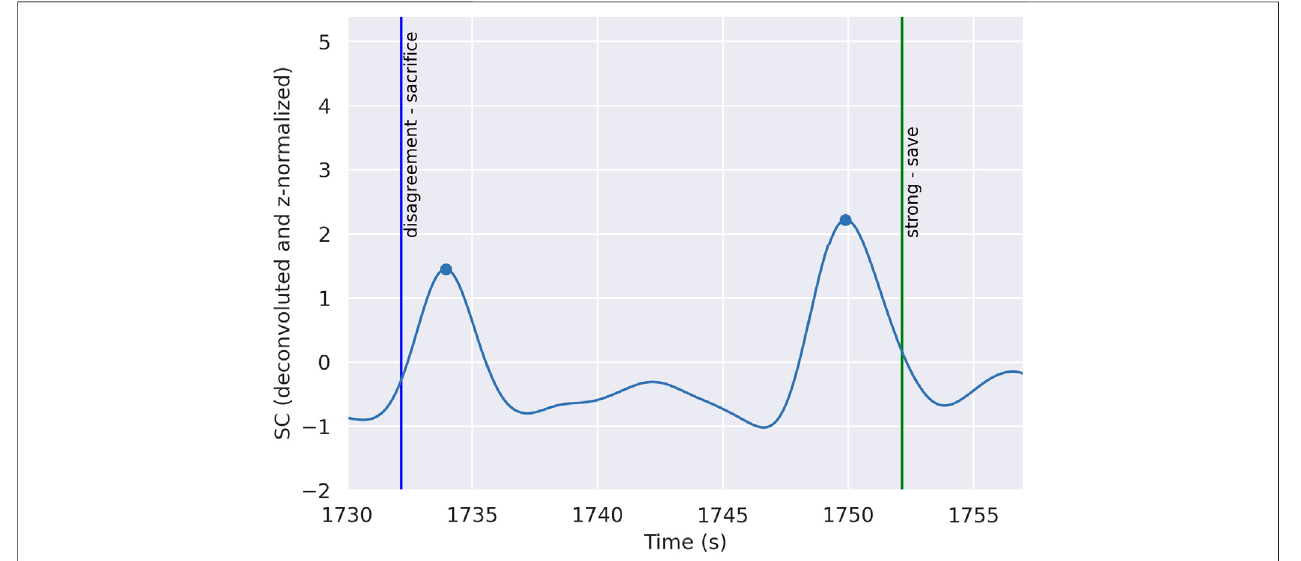
FIGURE1| Asampletimeseriesofadeconvoluted,z-normalizedSCsignal(depictedbytheblueline).ThebluedotsindicatethepeaksofindividualSCresponses. The blue vertical line indicates a responsive utterance and the green line an initiating utterance from the participant whose SC signal is depicted in the fi gure.